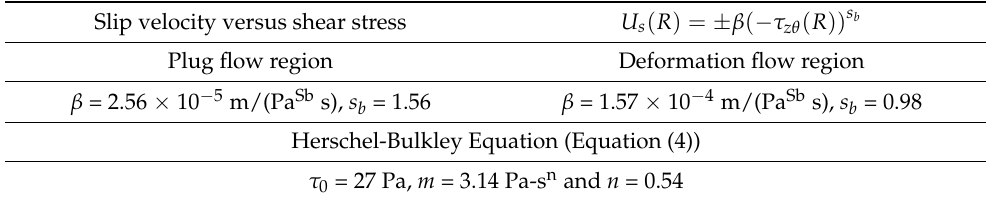
Table 1. The parameters of wall slip and shear viscosity.